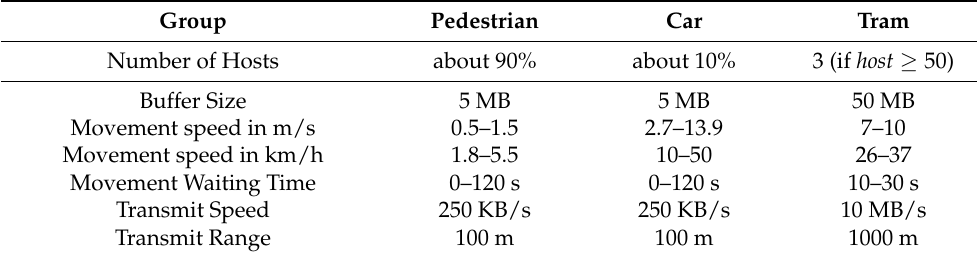
Table 2. Group configurations for running simulations for both cities. Group Pedestrian Car